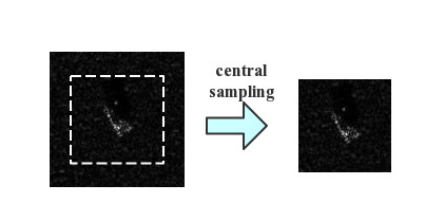
Figure 8. Illustration of central